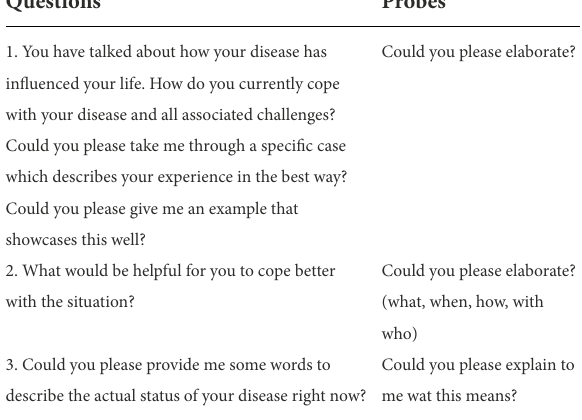
TABLE 1 Final version interview guide adolescents and young adult (AYA)